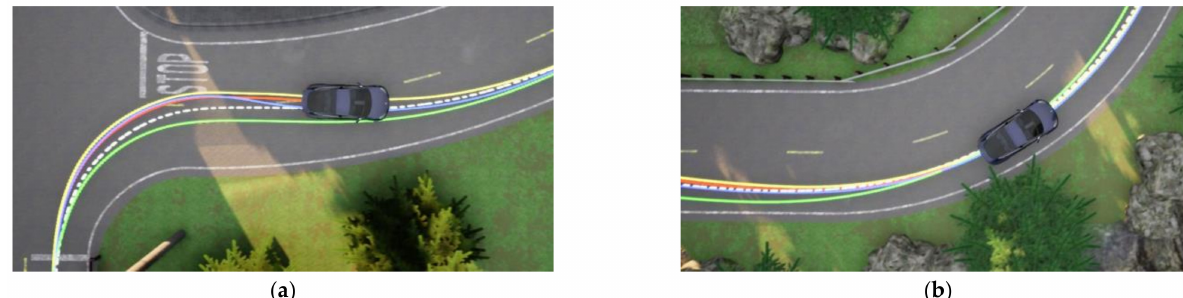
Figure 8. Tracking comparison of different control methods: ( a ) comparison of the first corner and ( b ) comparison of the last corner (the white line in Figure 8 represents the reference path; the green line represents the driving route of the pure pursuit method; the blue line represents the driving route of the MPC method; the yellow line represents the driving route of the DDPG method; the orange line represents the driving route of the DCN-DDPG method designed in this paper).